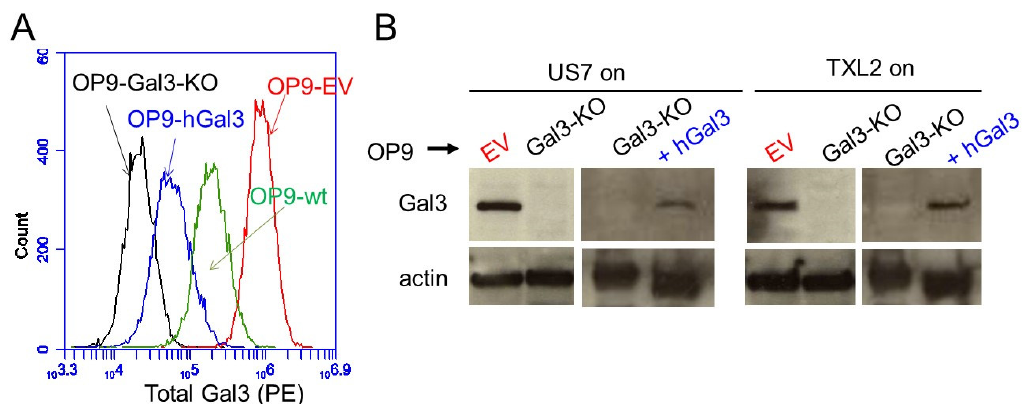
Figure 2. Protective stromal cells provide Gal3 to BCP-ALL cells. ( A ) Total Gal3 expression in 10,000 fixed and permeabilized OP9 stromal cells of the indicated genotypes. ( B ) Western blot of the indicated BCP-ALLs grown for >four days with OP9-EV, Gal3-KO or Gal3-KO + hGal3 cells. BCP-ALL cells were harvested from the medium.